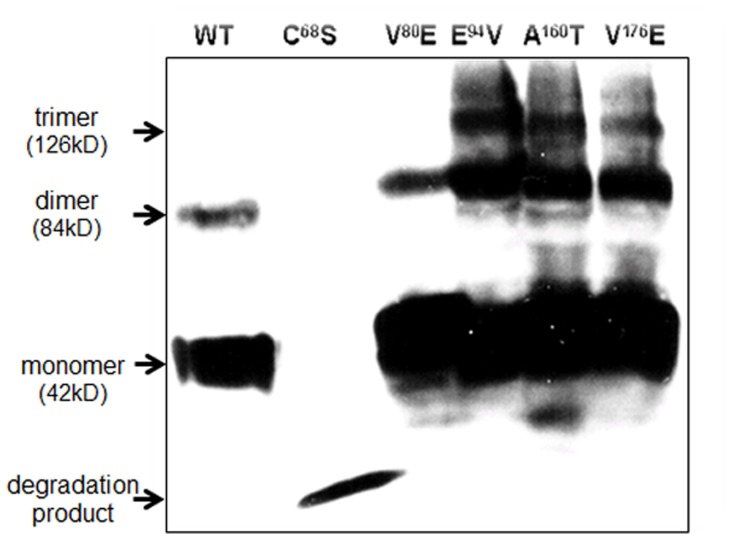
Western Analysis of Dysfunctional Variants.Western analysis for wild type hTP and the 5 dysfunctional mutations expressed in COS-1 cell membrane preparations. This was used to complement the saturation binding (folded protein) to assess for total cell surface expression (folded and misfolded). Monomers and oligomer formation is typical for GPCRs especially the misfolded variants. Shown are the approximate molecular weights in kD. The C68S demonstrated rapid degradation despite cocktails of protease inhibitors. This western analysis is representative of 4 performed.